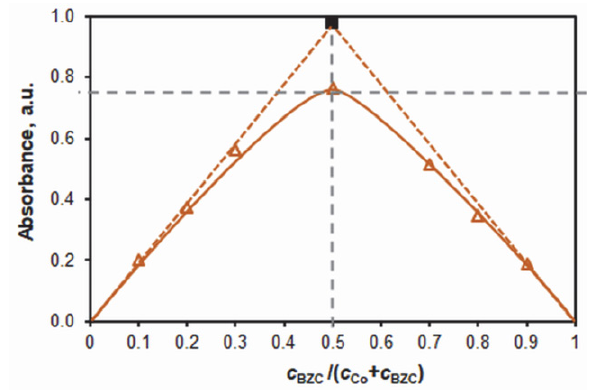
Figure 9. Determination of the BZC-to-Co molar ratio by the Job’s method of continuous variations and K ex by the